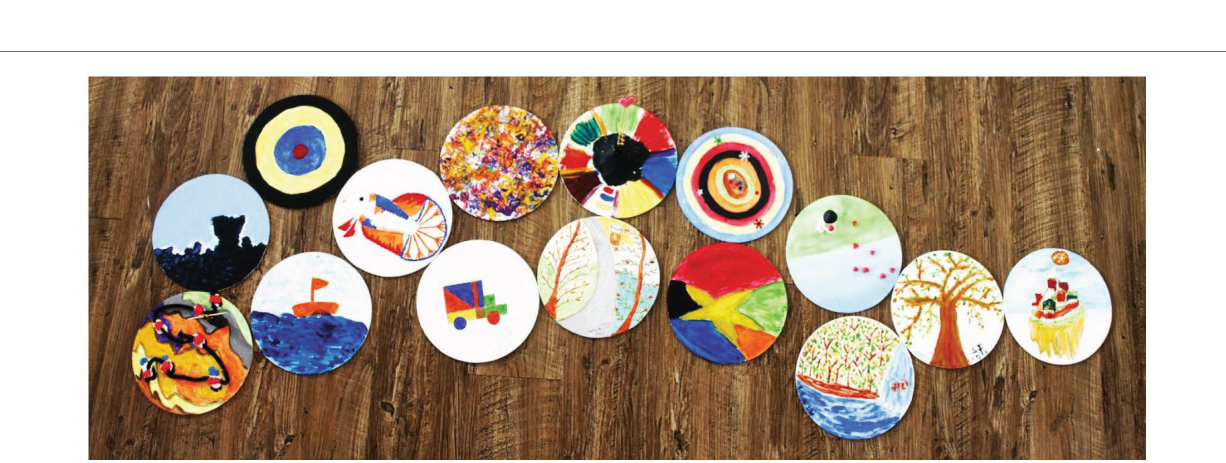
toward life and death with less rigid attachments for greater mental wellness. A large group mural created jointly by all participants of an MCAT group together with the therapists (see Figure 3 ) were illustrated by their poem entitled “Seasons of Life,” “Let the fallen leaves be the nourishment for next spring, together in this journey of life.”